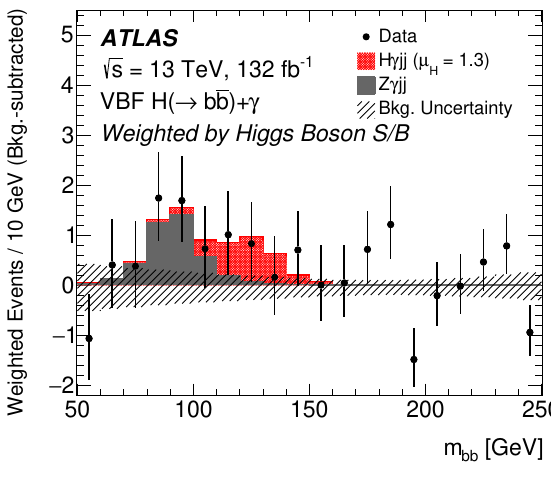
Figure 6 . The combined m bb distribution, after subtracting the (cid:12)tted non-resonant b (cid:22) b(cid:13)jj back- ground, summed over the three BDT categories weighted by S=B in each category, where S and B are the (cid:12)tted Higgs boson signal yield and Z(cid:13)jj + b (cid:22) b(cid:13)jj background yield, respectively, calculated in the mass window containing 68% of the Higgs boson signal. The expected contributions of H(cid:13)jj and Z(cid:13)jj are also shown, scaled by the (cid:12)tted Higgs boson signal strength and the Z(cid:13)jj normaliza- tion factors in the three BDT categories. The statistical uncertainty of the (cid:12)tted non-resonant b (cid:22) b(cid:13)jj background is represented by the hatched band. The statistical uncertainty on data is represented by the error bars on the data